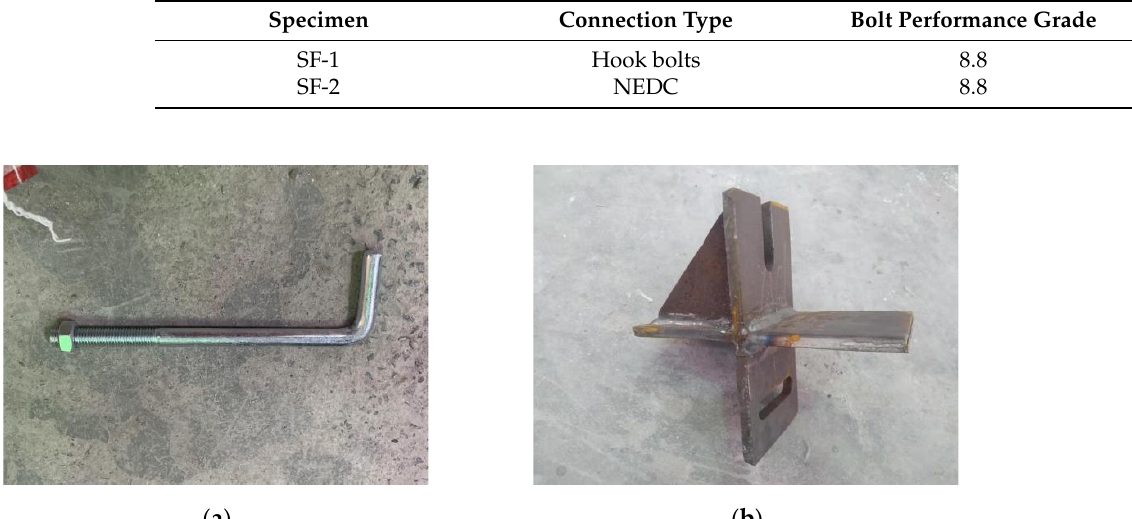
Table 1. Specimens used for the test and their characteristics.